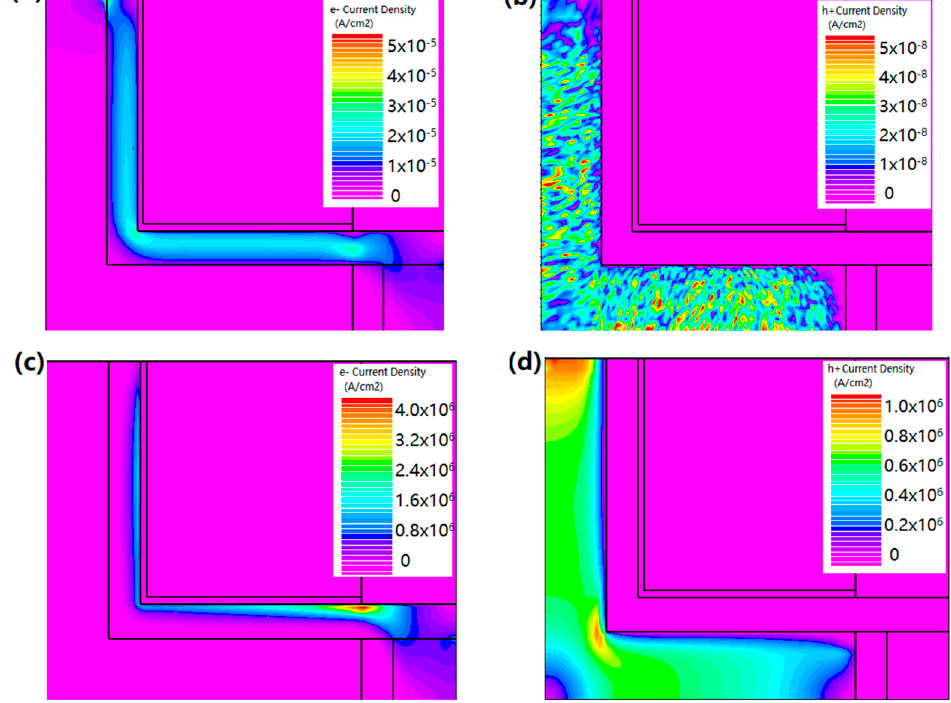
Figure 3. Simulated diagrams of ( a ) OFF-state electron current density, ( b ) OFF-state hole current density, ( c ) ON-state electron current density, and ( d ) ON-state hole current density at V DS = 0.5 V. The transfer characteristic curve simulated by Silvaco TCAD is shown in Figure 1b.